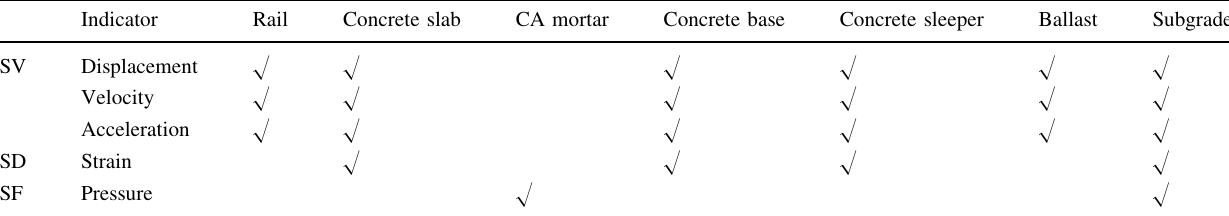
Fig. 2 Cross sections of the track structures in the test platform: a CRTS I slab track; b CRTS II slab track; c CRTS III slab track; d double- block ballastless track; e ballasted track Table 1 Measurement indicators of the test platform